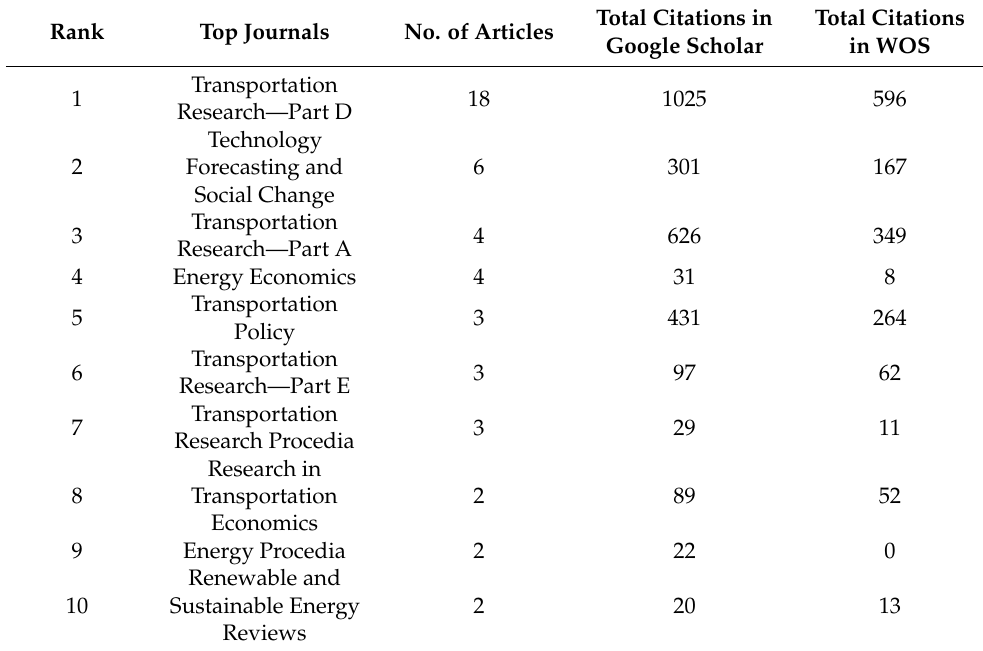
Table 1. Most influential journals in the research area under study.